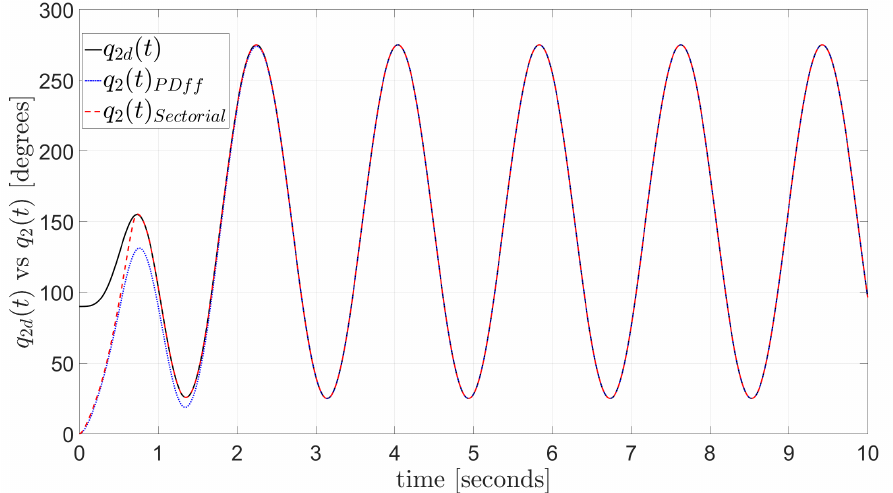
Figure 14. Desired vs. actual position in joint 2, without Coulomb friction.